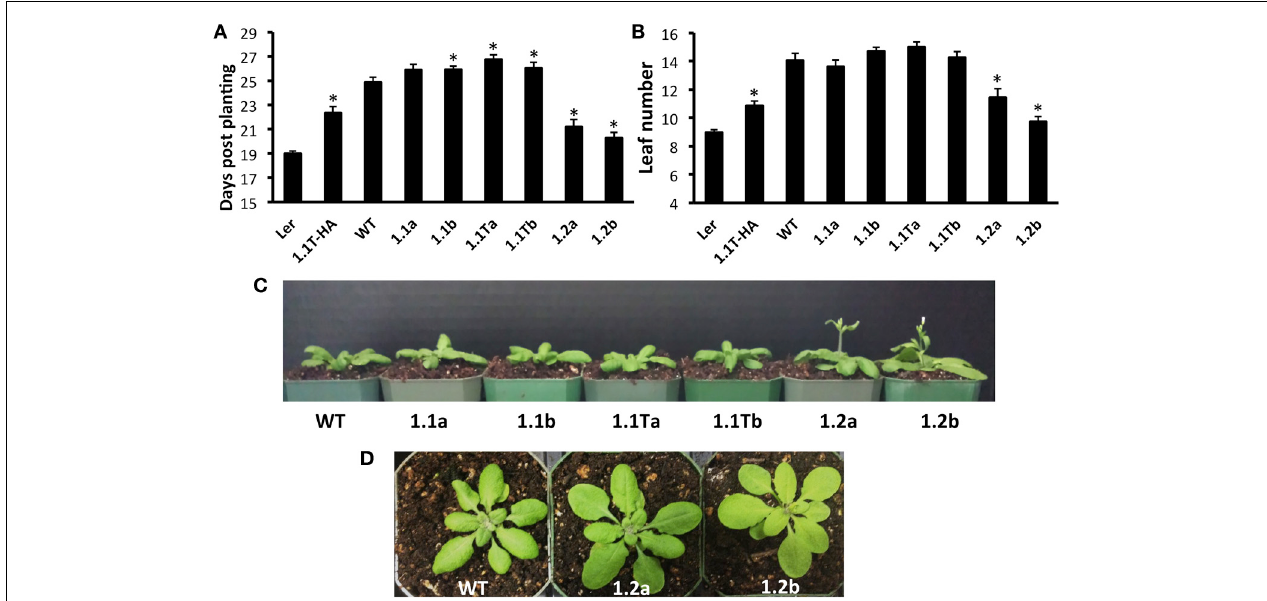
FIGURE 8 | Flowering Time Alterations in SnRK1 Transgenic Plants. (A) Days to flowering and (B) Number of leaves at flowering of soil-grown Arabidopsis wild type and SnRK1 overexpressing lines. (C) 21d plants (D) 23